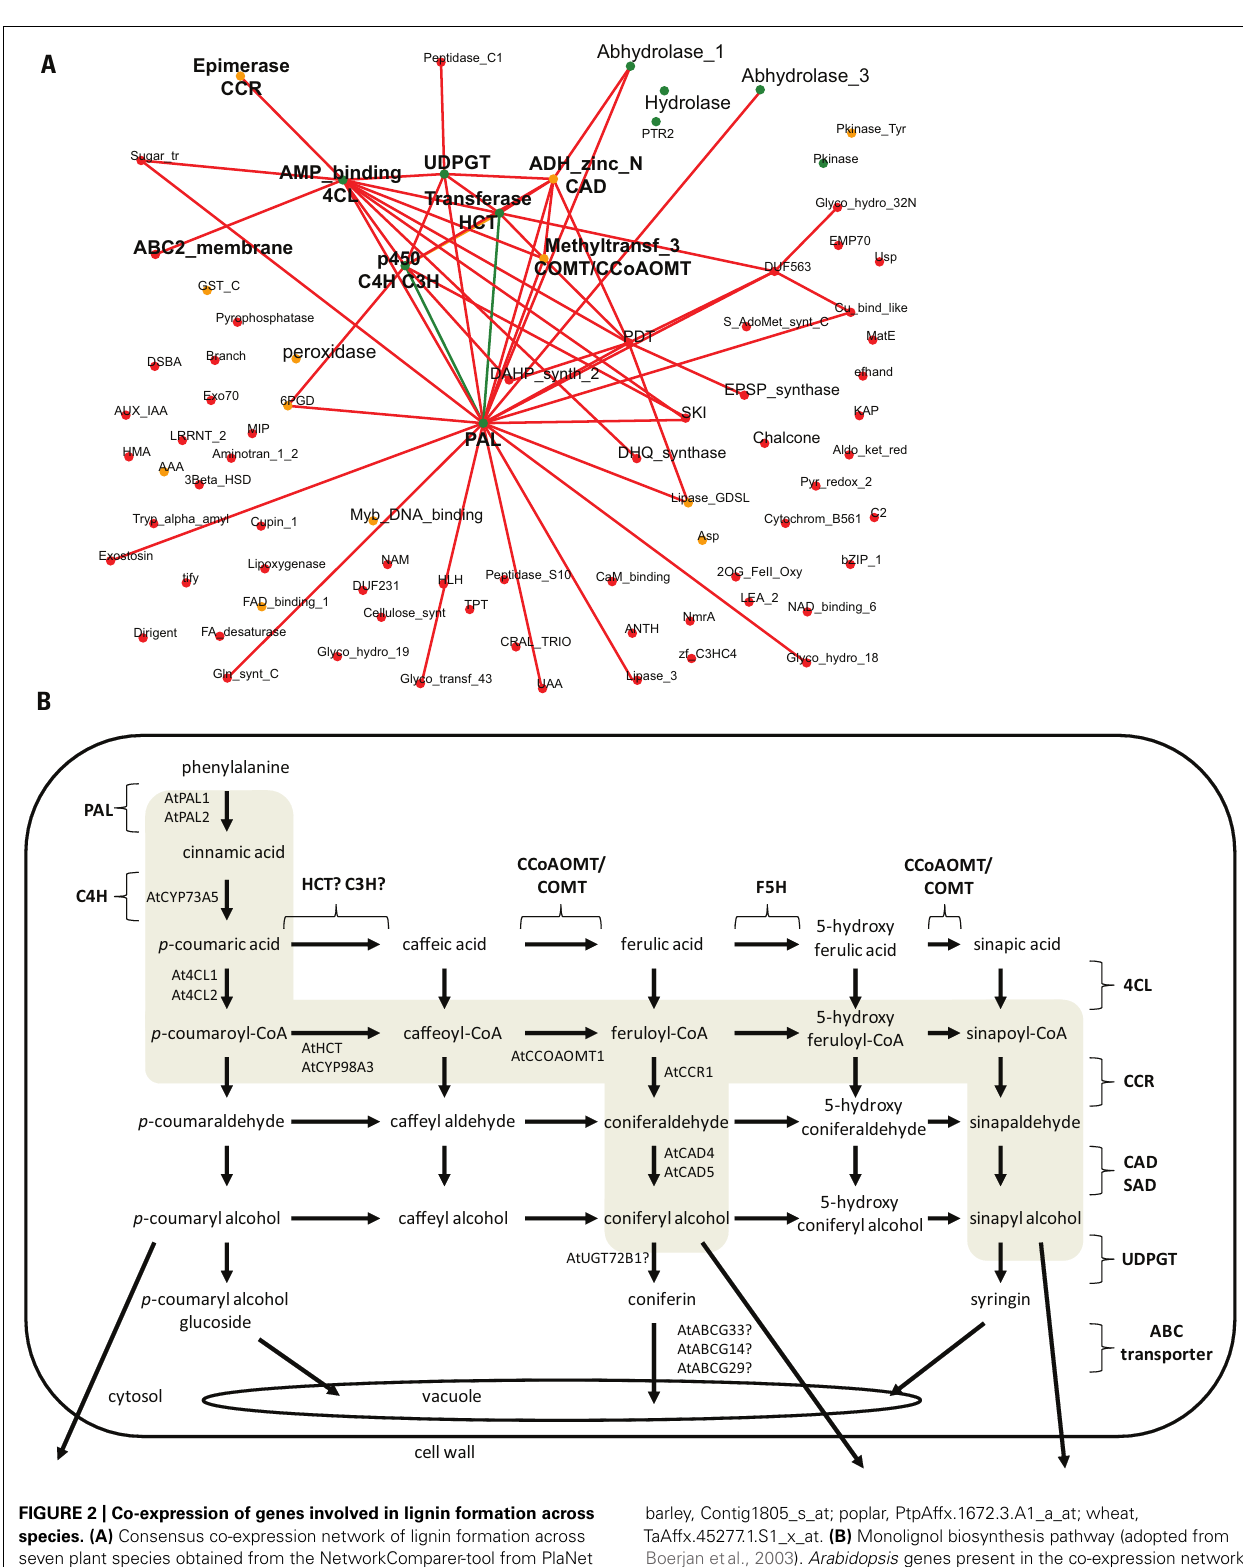
FIGURE 2 | Co-expression of genes involved in lignin formation across species. (A) Consensus co-expression network of lignin formation across seven plant species obtained from the NetworkComparer-tool from PlaNet (http://aranet.mpimp-golm.mpg.de/aranet/NetworkComparer). Co-expression network of following genes/probeset IDs were used: Arabidopsis , At2g37040; rice, LOC_Os02g41650; Medicago, Medtr1g076720;